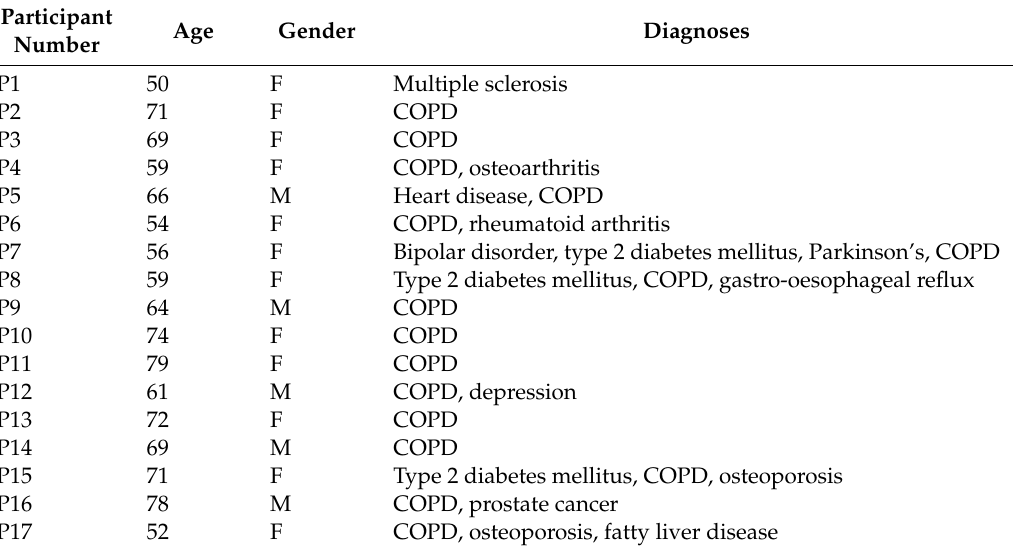
Table 2. Demographic information for study participants.